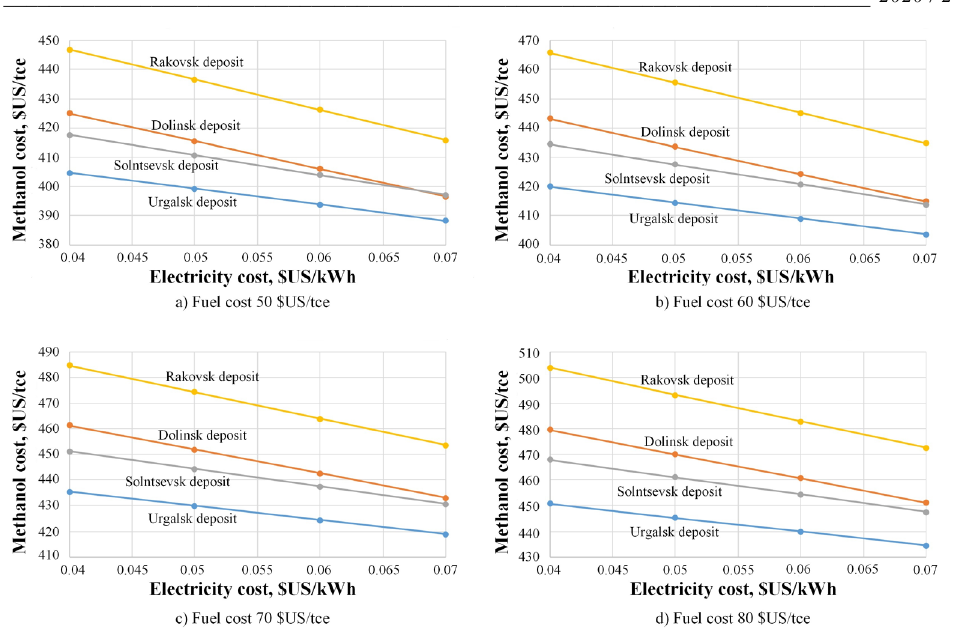
Fig. 4. Dependences of the methanol cost on the electricity cost at the set coal